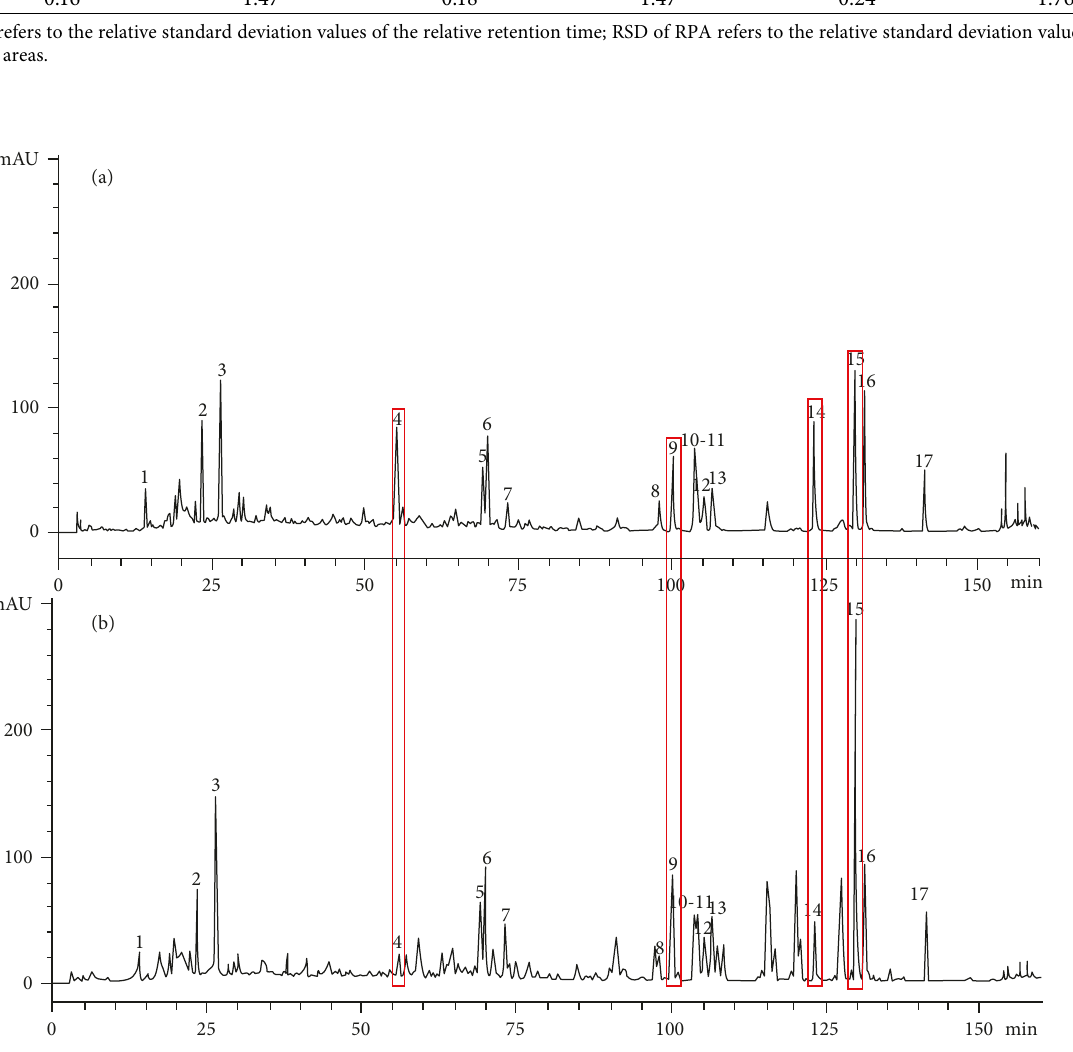
Figure 1: The example of HPLC chromatograms of M2 (a) and F4 (b). The chromatographic peaks of the known compounds: 4, siebolside B; 5, isograndidentatin A; and 12, sakuranetin. The X axis refers to the retention time (t/min). The Y axis refers to the response value